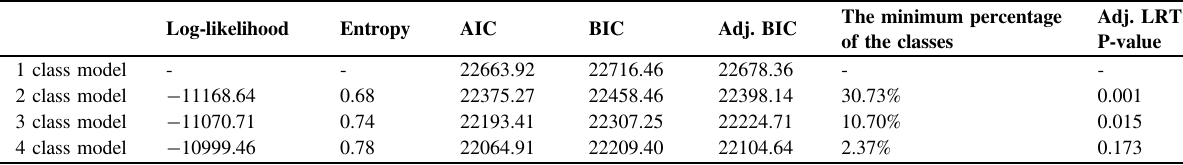
Table 2 Latent class fi t